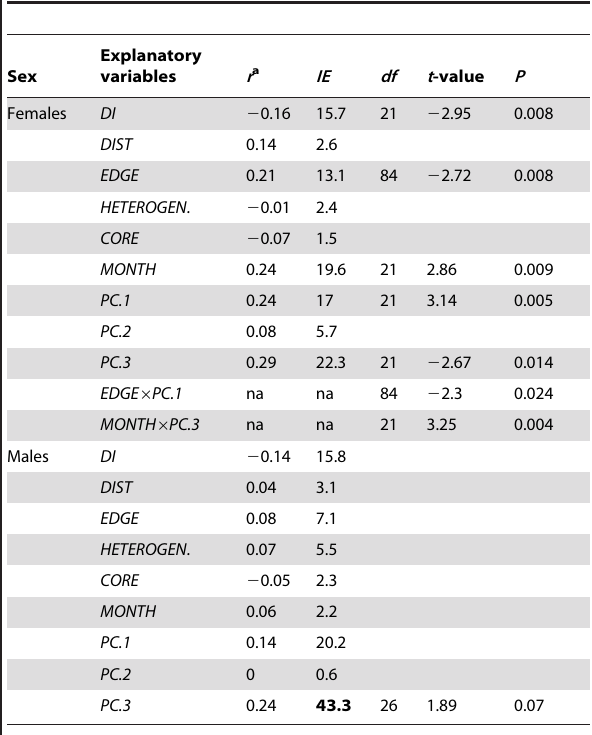
Table 11. Relationships between lymphocytes (cells ? L 2 1 ) and environmental variables for agile antechinus.